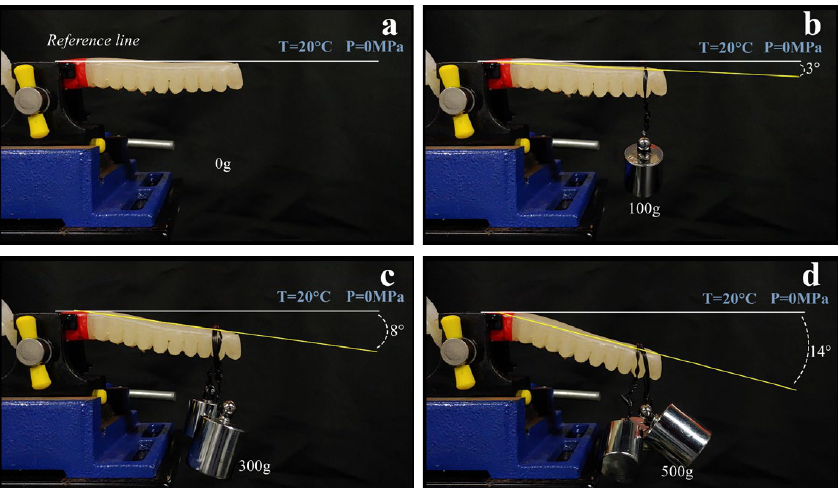
Figure 4. Demonstration of the load-bearing capability of the actuator at 20 ◦ C and 0 MPa. ( a ) The actuator is in its initial state with no weight suspended. The white line denotes reference. ( b ) Bending of the actuator when 100 g weight is suspended. The yellow line represents the bending profile of the actuator. ( c ) Bending of the actuator when 300 g weight is suspended. ( d ) Bending of the actuator when 500 g weight is suspended. The stiffness variation of the actuator at different temperatures and pressures is shown in Movie